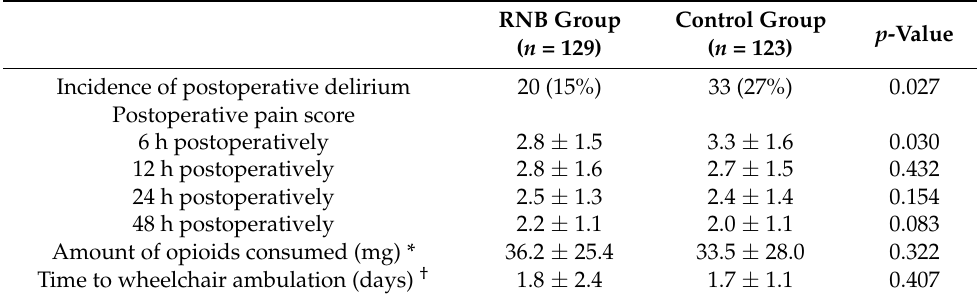
Table 3. Comparison of the postoperative pain score, incidence of delirium, amount of opioids consumed, and time to wheelchair ambulation.